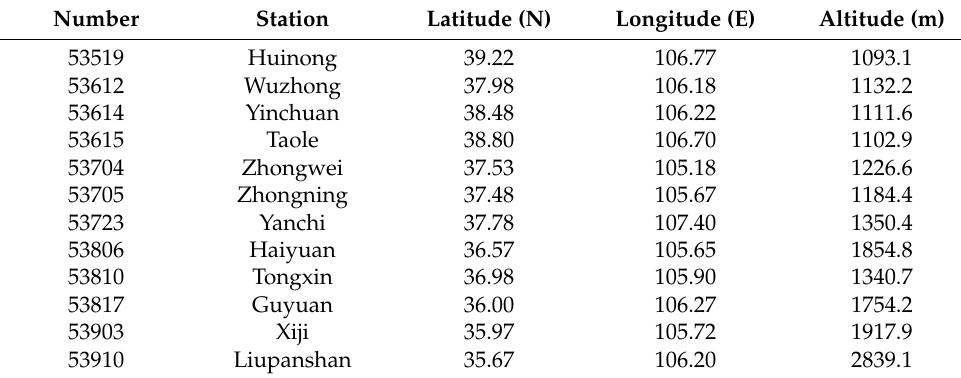
Table 3. Meteorological station used in this